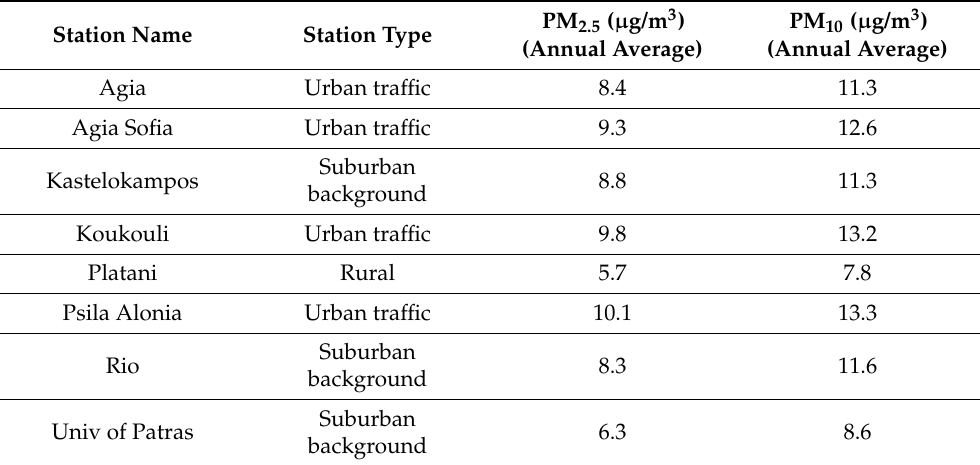
Figure 1. Spatial distribution of the eight air quality monitoring stations used in this study. Black squares denote the CAMS grid points. Table 1. The types of monitoring stations used in the study and their annual PM